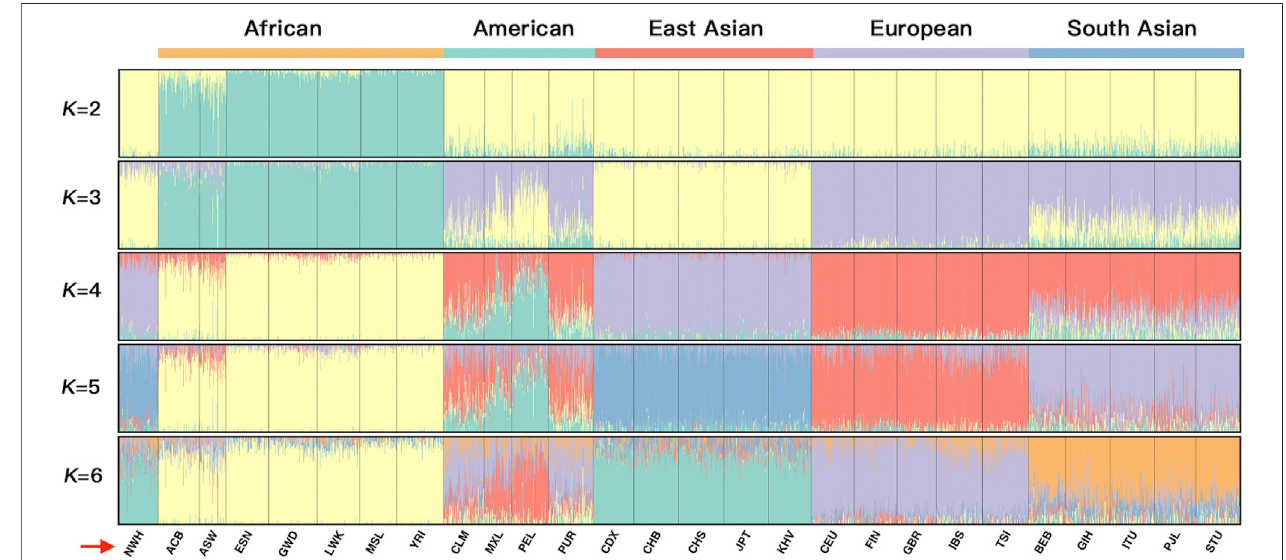
FIGURE8| ASTRUCTUREplotforthe26referencepopulationsandtheNorthwestHuigroupbasedontherawpopulationdatafor55AISNPsfrom K (cid:2) 2to K (cid:2) 6. The K values are equivalent to the predicted ancestral components shown in different colors. AISNPs, ancestry-informative single-nucleotide polymorphisms.